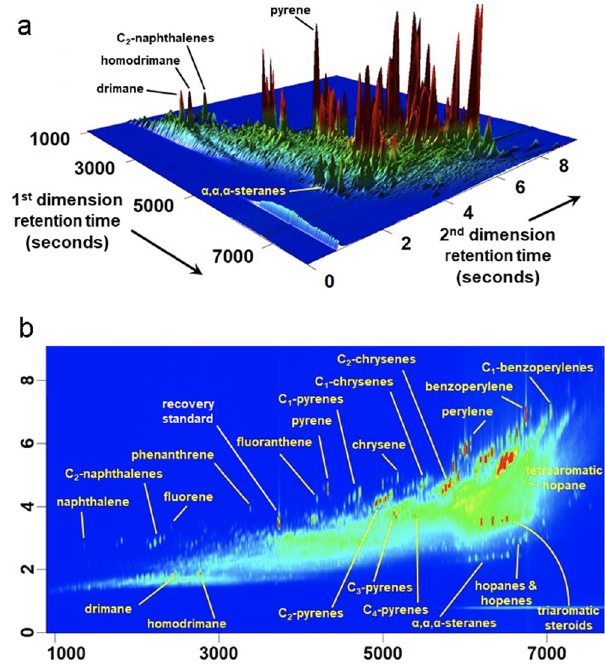
Fig. 3 Solvent extractable material from Cathedral Hill Sediment core 4991-7. The 0 – 6 cm section, is shown as a 3D GC×GC-HRT mountain plot ( a ) and as color contour plot of the same GC×GC-HRT chromatogram ( b ). Annotated peaks include polynuclear aromatic hydrocarbon (PAHs) compounds as well as sesquiterpanes, hopanes, steranes, di- and triaromatic steroids, and tetraaromatic